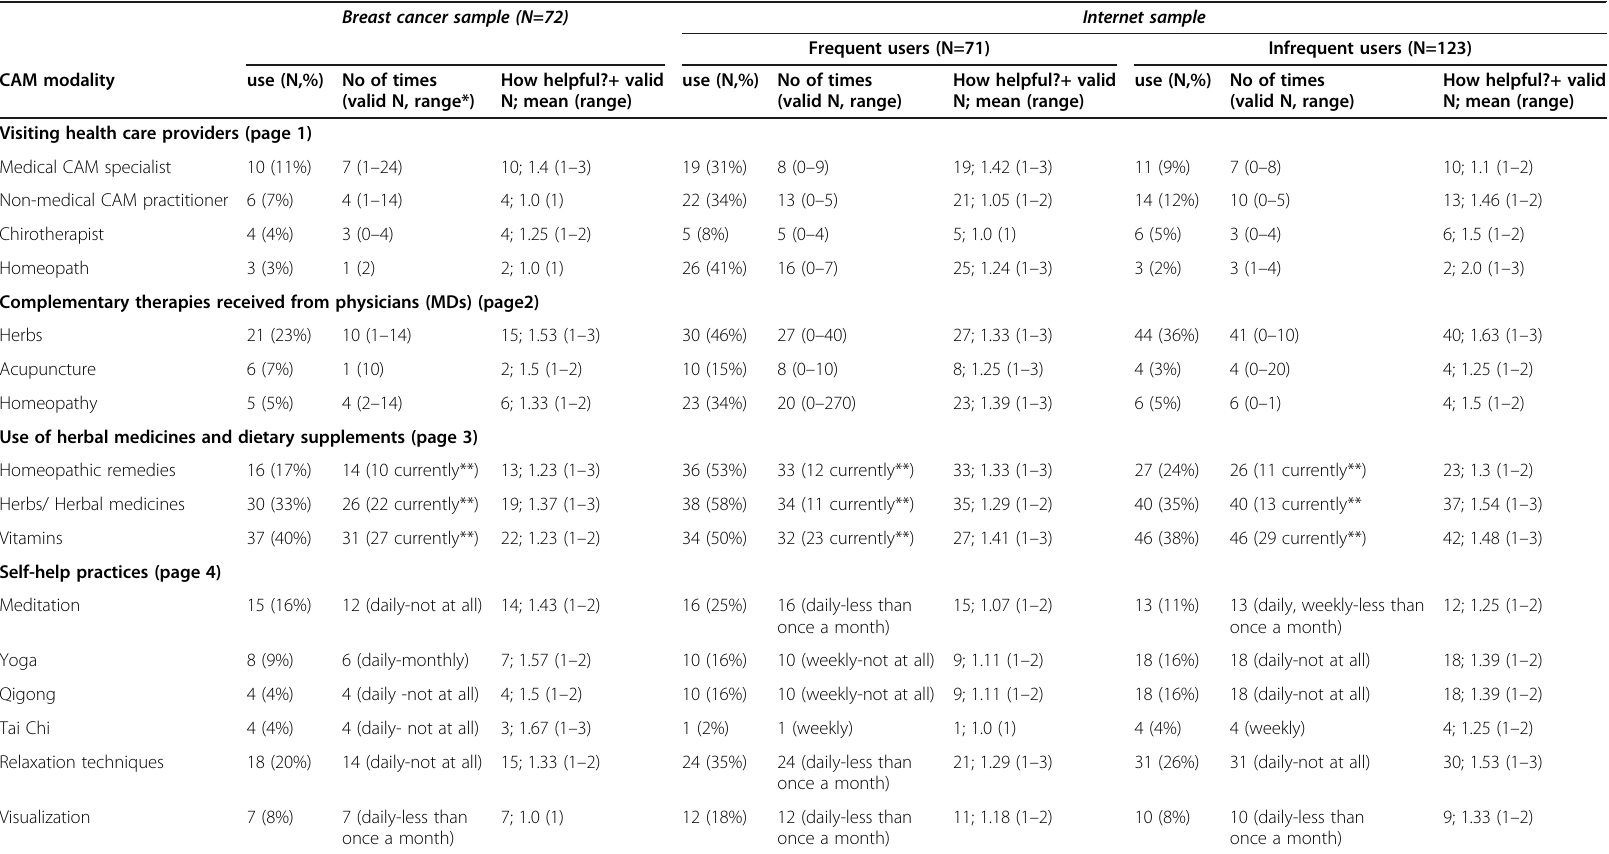
Table 2 Rates of CAM usage and subjective